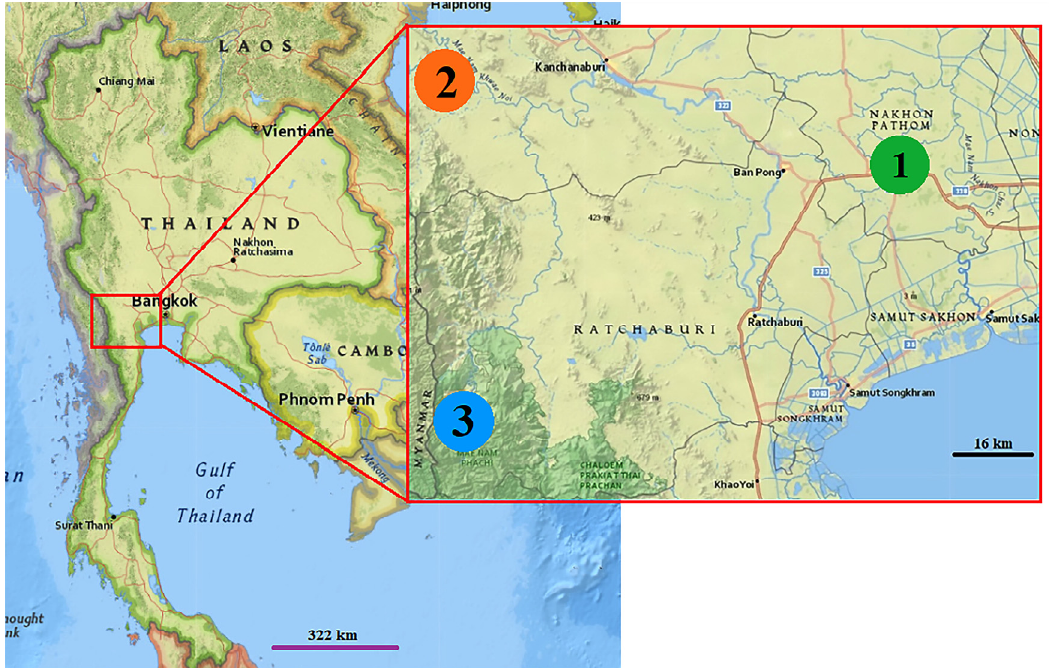
Figure 1. Study sites for mosquito sample collection in this study. This geographical map was taken from the USGS National Map Viewer (the public domain) at http://viewer.nationalmap.gov/viewer/ (accessed on 9 November 2022). Mosquito samples were collected from Nakhon Pathom (1, Green) in the central region, Kanchanaburi (2, Orange), and Ratchaburi (3, Blue) in the western region of Thailand.